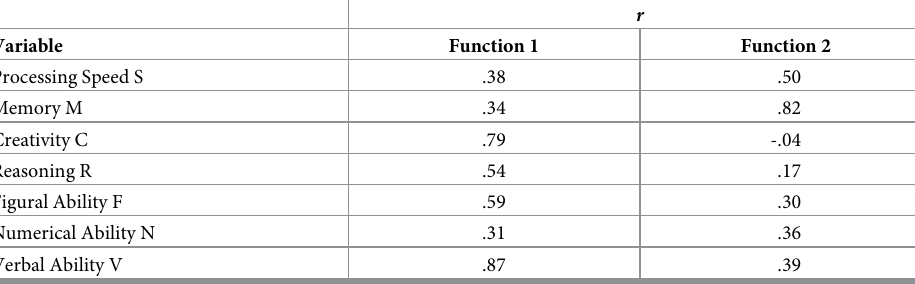
Table 6. Structure coefficients of the discriminant Function 1 and Function 2 in Analysis